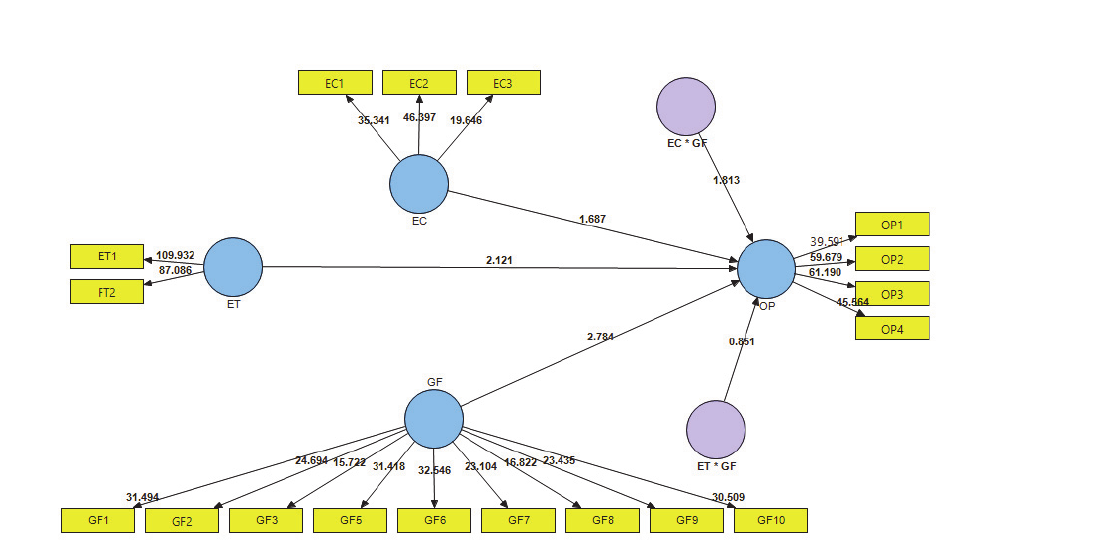
Fig. 3. Moderation Results